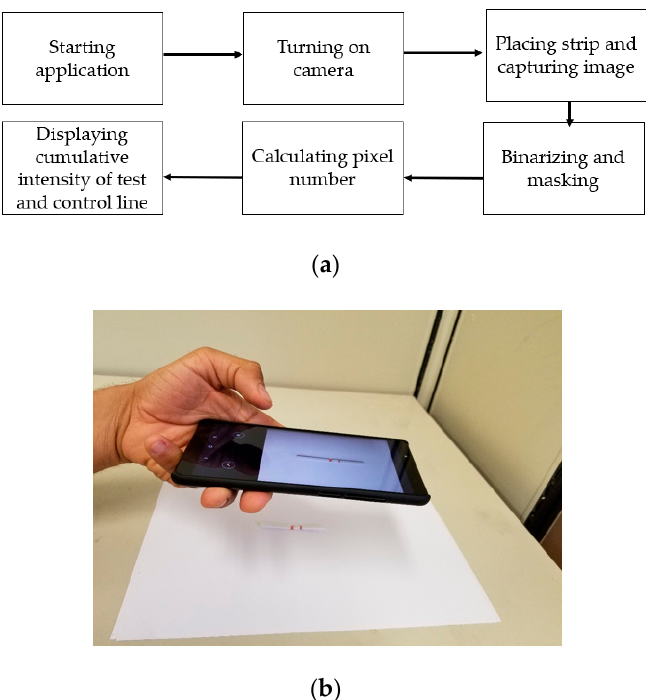
Figure 11. ( a ) The flowchart describing the subsequent operations of our developed application; ( b ) the data acquisition procedure with accurate placement using our developed application.